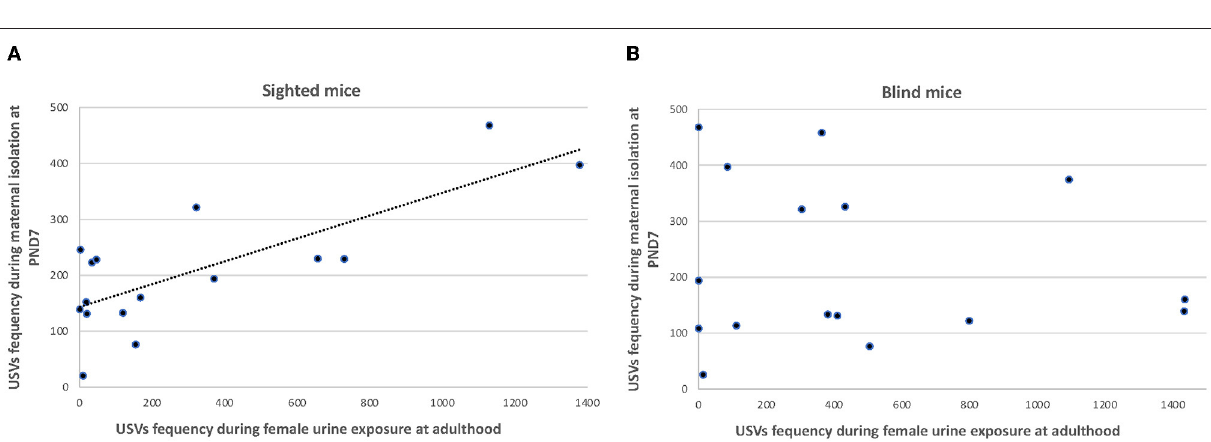
congener (Brodkin, 2007; McFarlane et al., 2008) and increased time allocated to self-grooming and inactivity (McFarlane et al.,